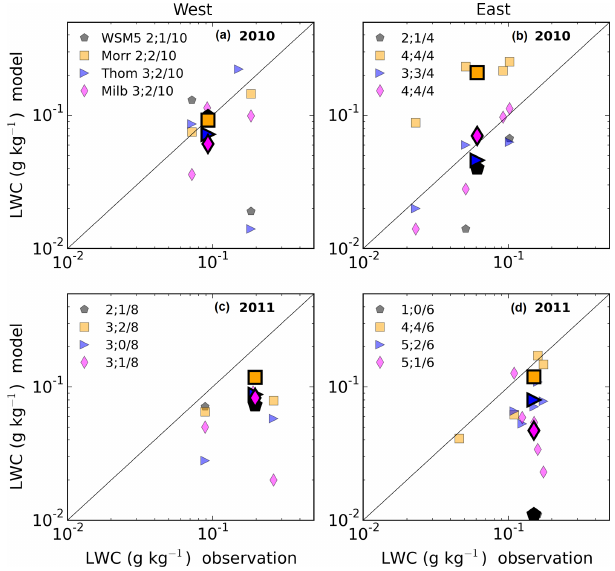
Figure 6. Scatter plot of simulated LWC versus observed LWC in 2010 (a, b) and in 2011 (c, d) on the western side of the penin- sula (a, c) and on the eastern side of the peninsula (b, d) . Light markers show averages per flight track, while bold markers give the average of all the tracks on each side of the peninsula. The numbers next to each scheme’s marker in the legend ( n 5 ; n 50 /N ) gives the number n 5 ( n 50 ) of simulated flights with a simulated LWC at least 5% (50%) of the observed LWC to the total number N of flights measuring an average LWC. Note that in panel (c) the bold markers (total average) overlay some light markers (flight averages), which explains the actual higher position of the total average on the graph compared to the other discernible lower flight